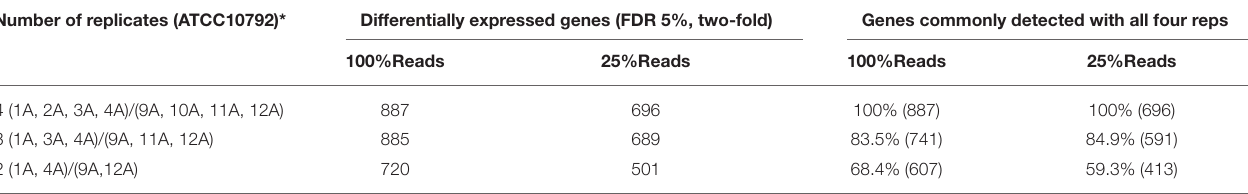
TABLE 4 | Effect of decreasing number of replicates on significantly differentially expressed genes while maintaining 100 and 25% of the reads. Number of replicates (ATCC10792)*